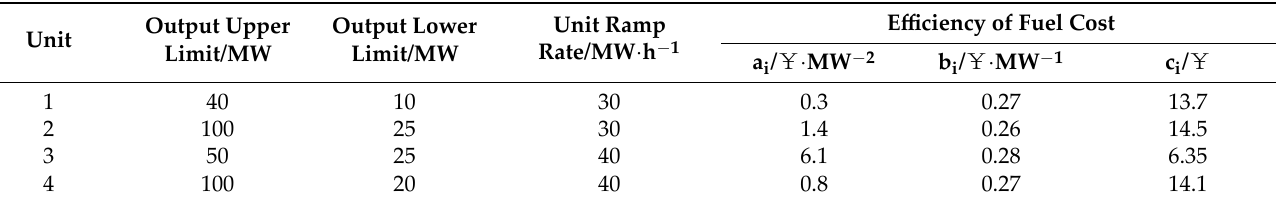
Table 1. Parameters of the thermal power units.